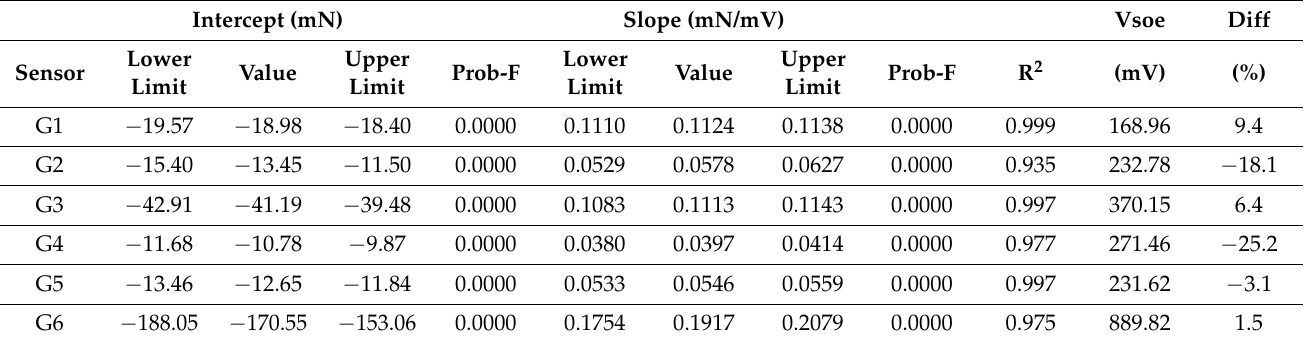
Table 3. Statistical parameters of the linear model between load and instrumental signal ( p <